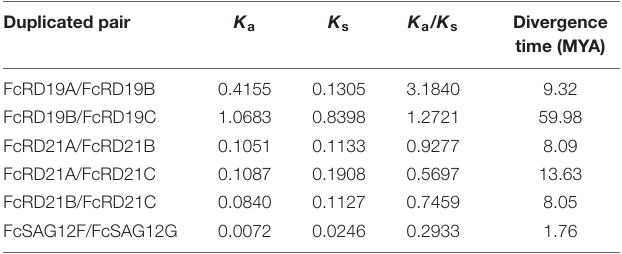
TABLE 1 | K a / K s calculation and divergence time of the duplicated FcPLCP gene pairs. Duplicated